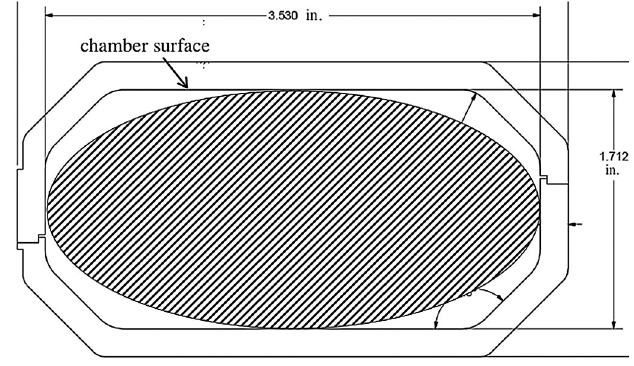
FIG. 1. Wiggler vacuum chamber with elliptical vacuum chamber used in simulations superimposed